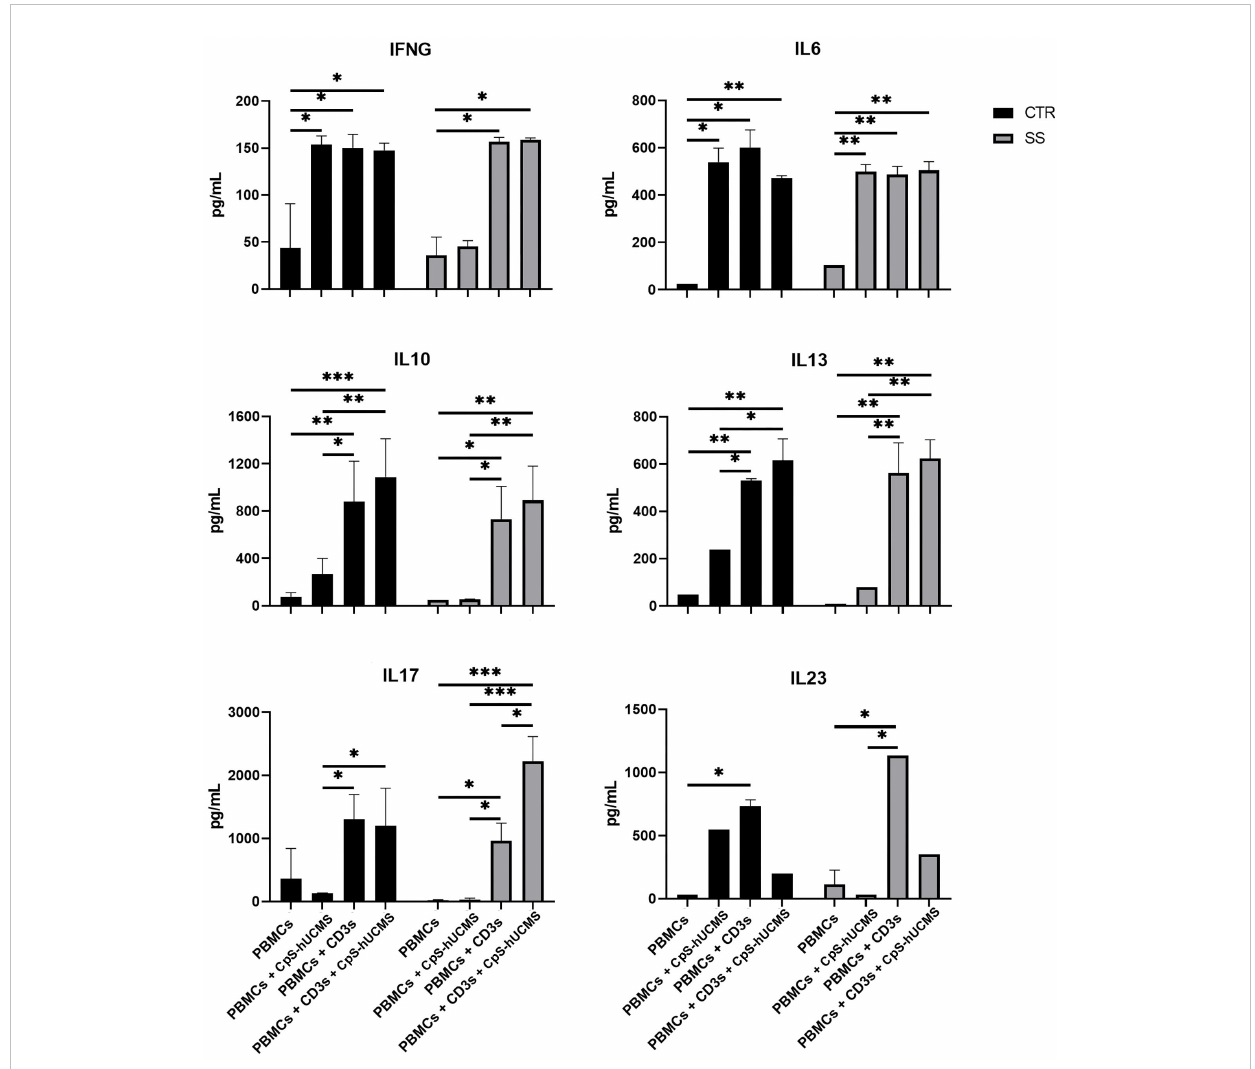
FIGURE 5 Amount of indicated cytokines (pg/mL) released in the supernatant from PBMC of control and Sjogren patients after 5 days of culture with or without CpS-hUCMS (pretreated with IFN g 2400Y/10 6 cells) and with or without CD3s. All results were expressed as mean ± S.D. (*P<0.05, **P<0.005,